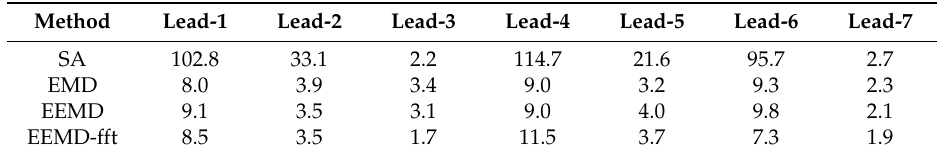
Figure 8. Example clinical case: Patient #10, illustrating output of processing each bipolar arm lead using the various denoising methods. X-axis are in samples (2048 samples/sec), y-axis are in automatic scaled units. Table 2. SNR (signal-to-noise ratio) mean value figures (N = 34) for denoising performance comparison among the denoising methods under study.